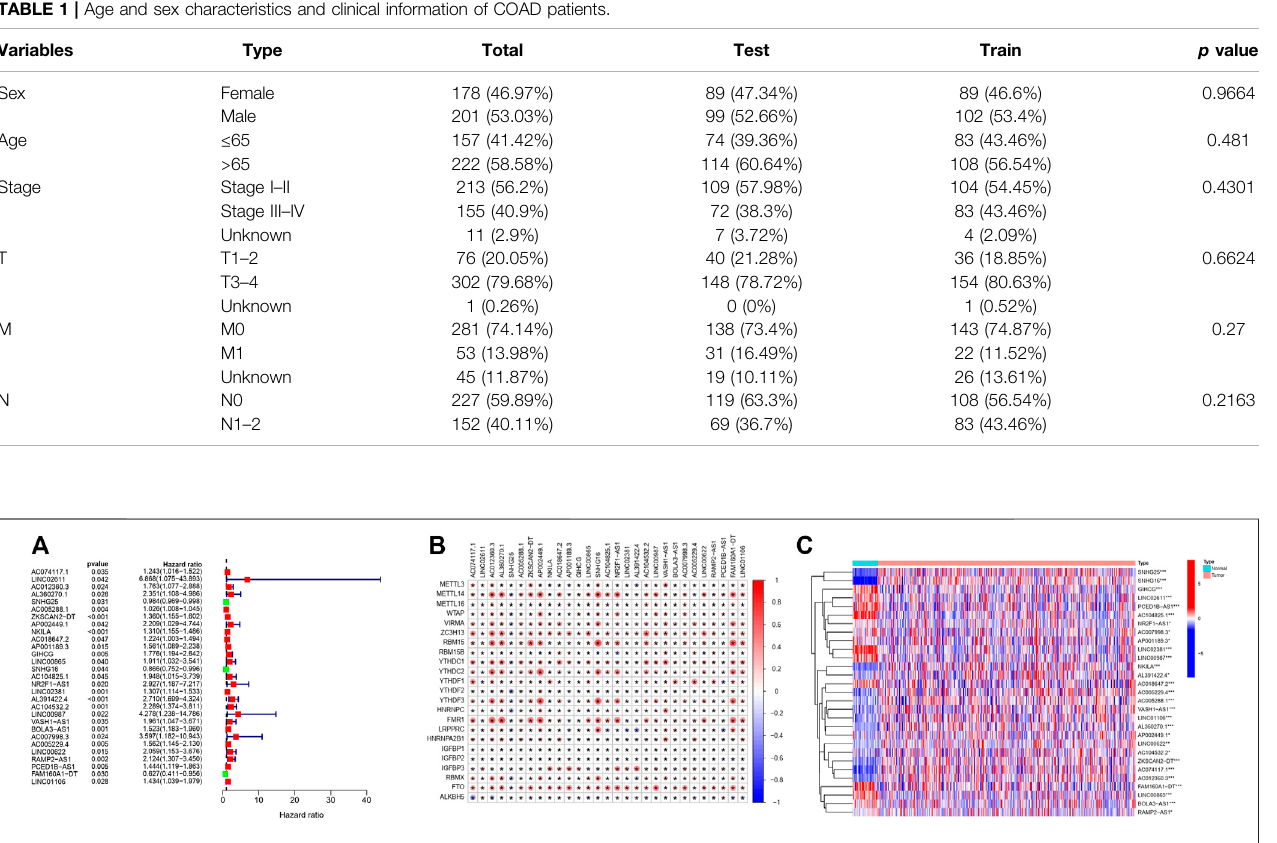
Frontiers in Cell and Developmental Biology |